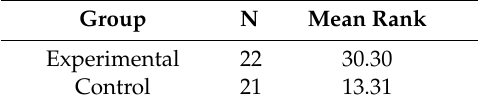
Table 12. Results from the non-parametric Mann–Whitney U test.